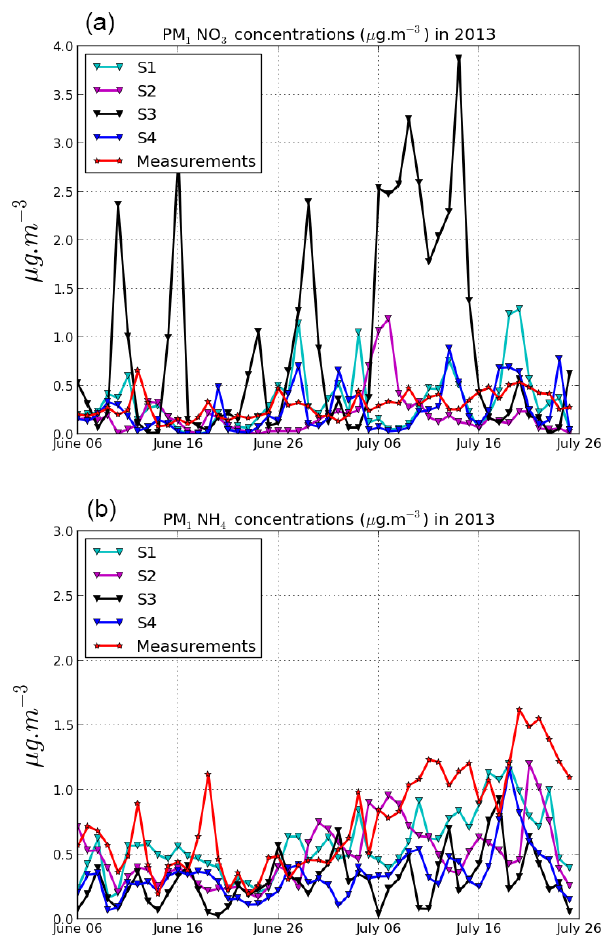
Figure C3. Comparisons of simulated and observed PM 1 nitrate (a) and PM 10 ammonium (b) concentrations at Ersa during the summer